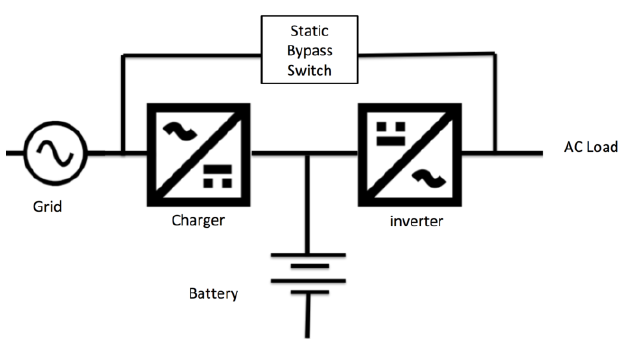
Figure 4. Typical Uninterrupted Power Supply (UPS) setup.